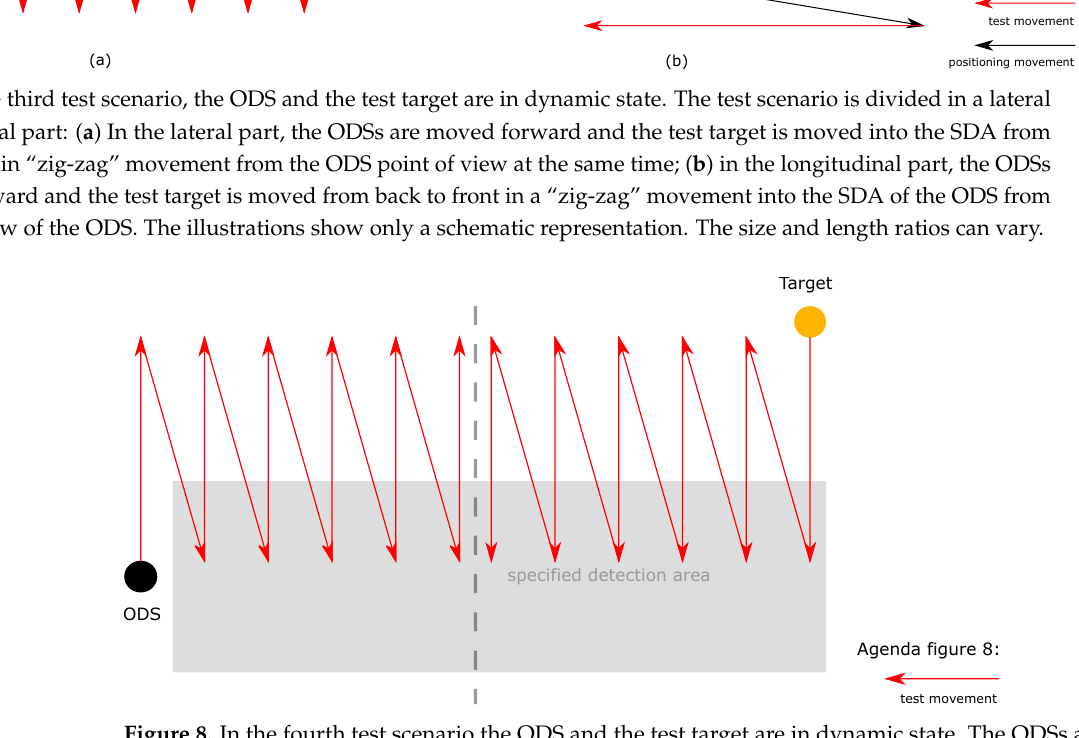
Figure 8. In the fourth test scenario the ODS and the test target are in dynamic state. The ODSs are moved from the left and right in a “zig-zag” movement and the test target is moved in the opposite direction to the ODS from right to left in a “zig-zag” movement from back to